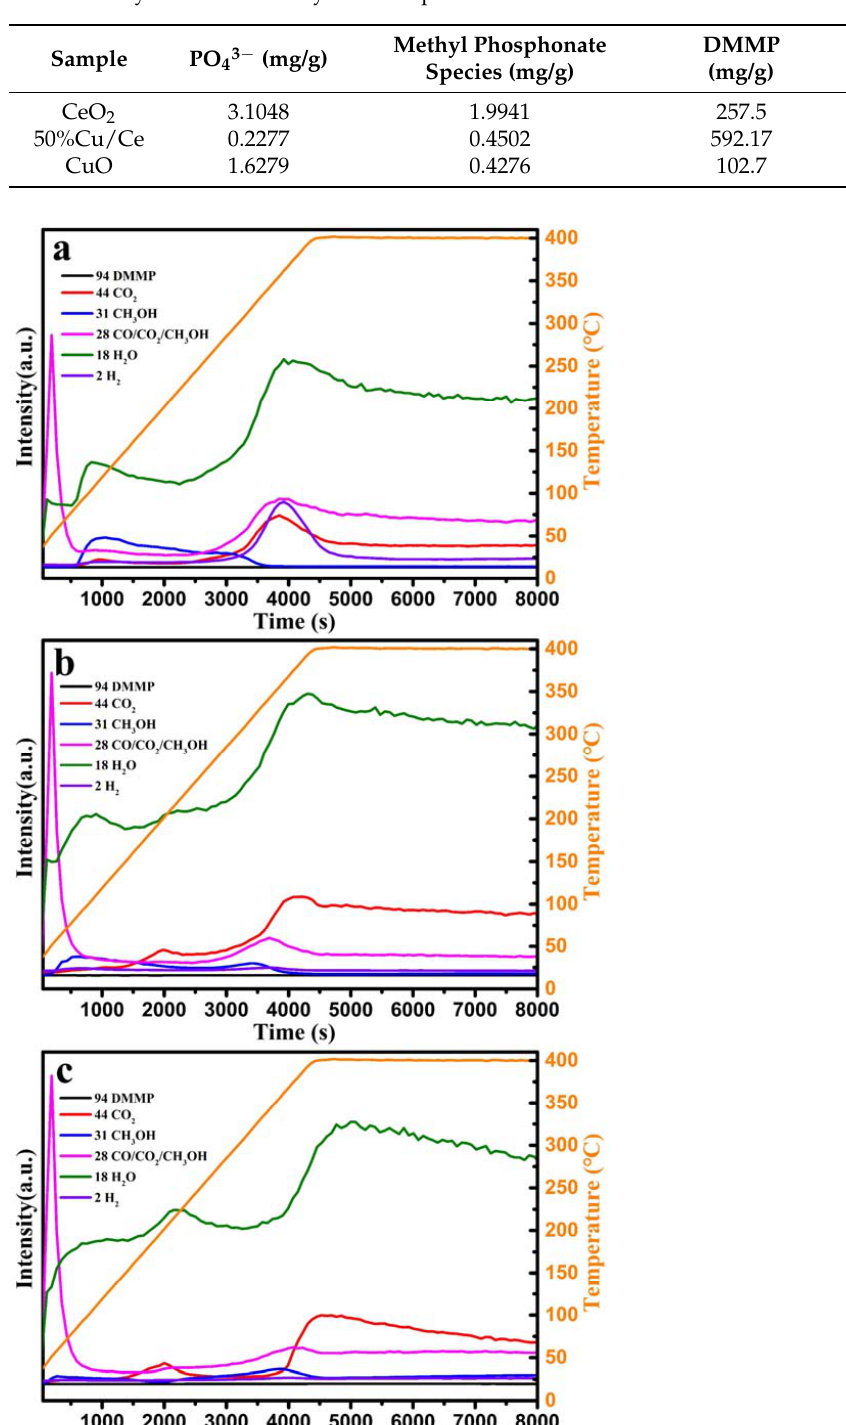
Table 7. Content of PO 43 − , methyl phosphonate species, DMMP decomposition, and P element on various catalysts after the catalytic decomposition of DMMP.